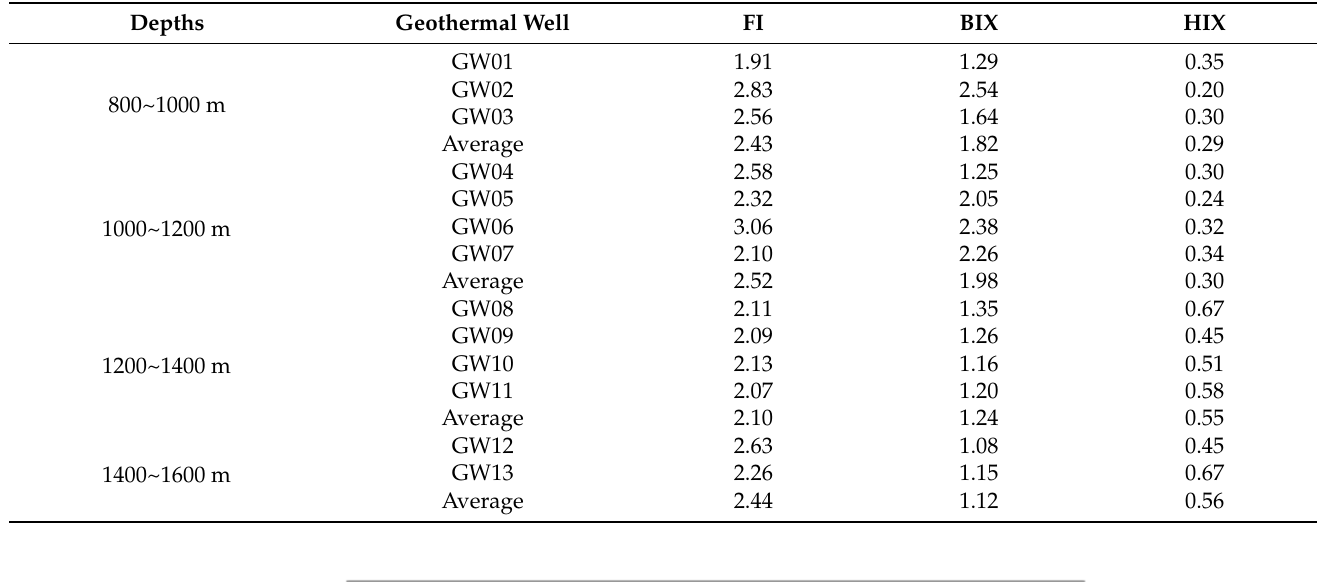
Table 1. Fluorescence index (FI), biological index (BIX), and humification index (HIX) of geothermal water in different reservoirs.